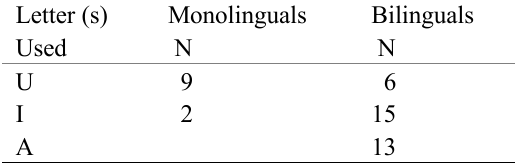
Table 10. Misspellings for the phoneme / ə / in